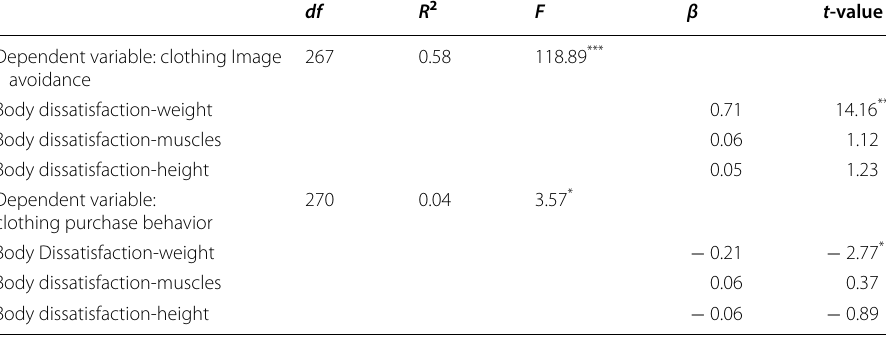
Table 4 Multiple regression analysis for body dissatisfaction predicting clothing image avoidance and clothing purchase